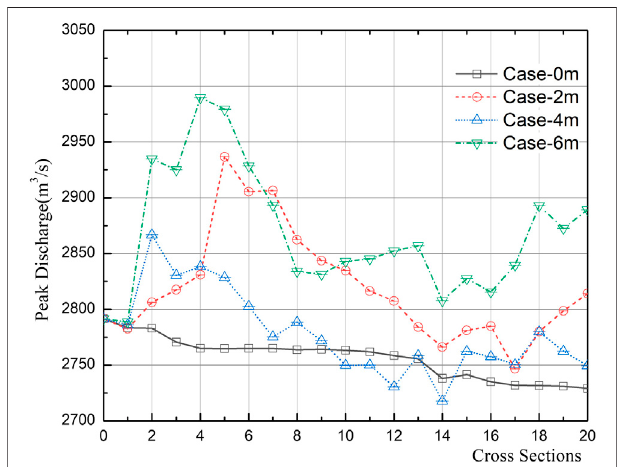
Frontiers in Earth Science |